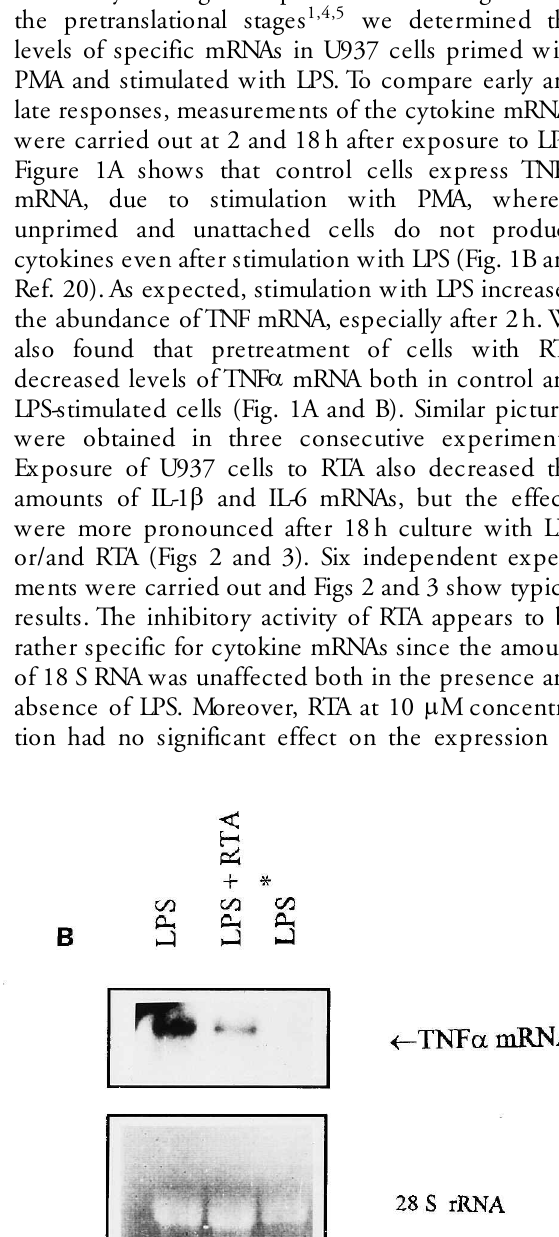
Table 1. Total concentrations (supernatants + cell lysates) of cytokines (ng/ml) in U937 cells after 24h of culture with RTA (10 m M) or LPS (500ng/ml), or RTA and LPS. All cells were primed with PMA as described in Materials and Methods. Mean of four to five experiments; ±SD. The statistical differences were evaluated by paired Student’s t -test in pairs: